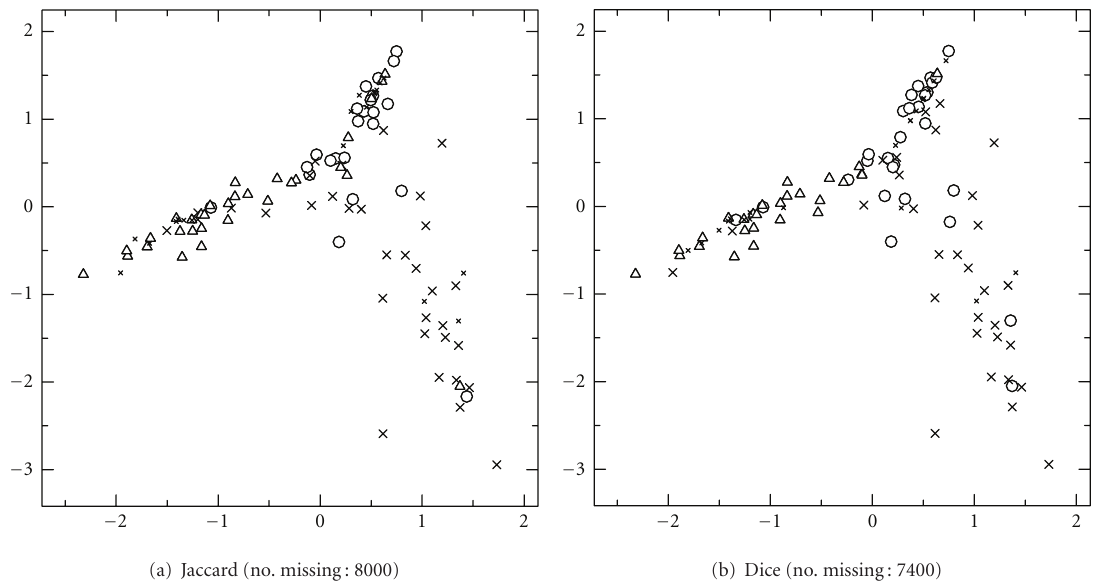
Figure 7: Comparison of cluster partition of Fuzzy c -Medoids for incomplete “Kokoro” text data derived with Jaccard’s and Dice’s coe ffi cients imputed by maximin